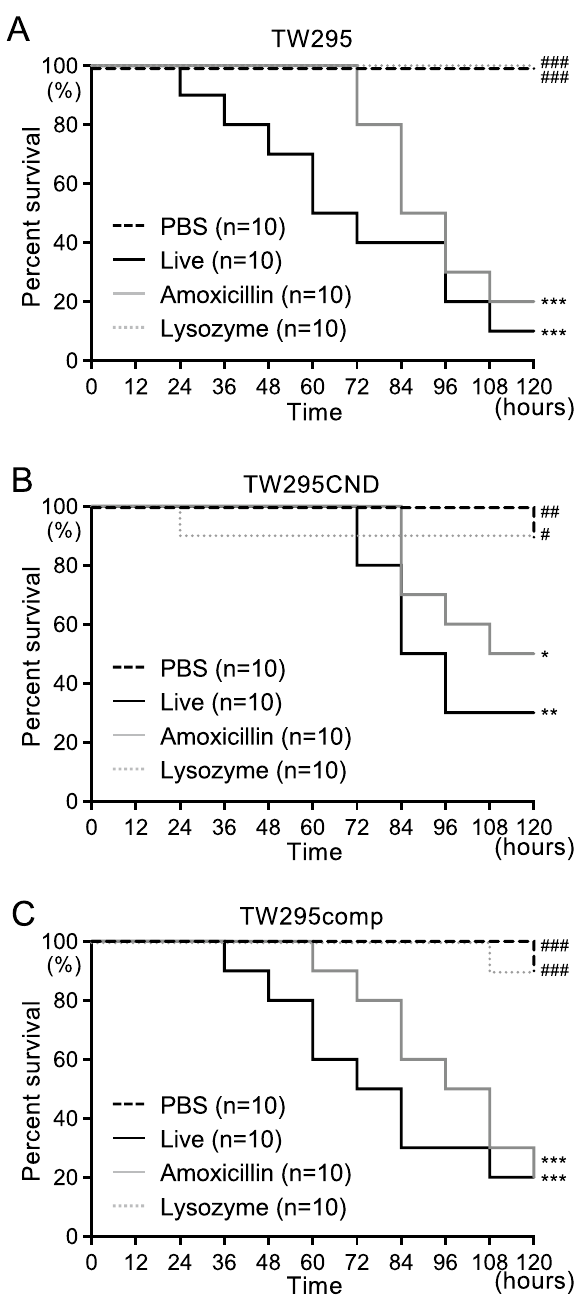
Figure 4. Survival curve for silkworm larvae administered with live S. mutans , amoxicillin-killed S. mutans , and lysozyme-killed S. mutans . Silkworm larvae infected with 1 × 10 7 CFU of ( A ) TW295 (Cnm +), ( B ) TW295CND (Cnm−), and ( C ) TW295comp (Cnm +). Survival rates in each group were evaluated in a Kaplan– Meier plot, which was analyzed by a log-rank test. * P < 0.05, ** P < 0.01 and *** P < 0.001 versus phosphate-buffered saline group; # P < 0.05, ## P < 0.01, and ### P < 0.001 versus live S. mutans administration